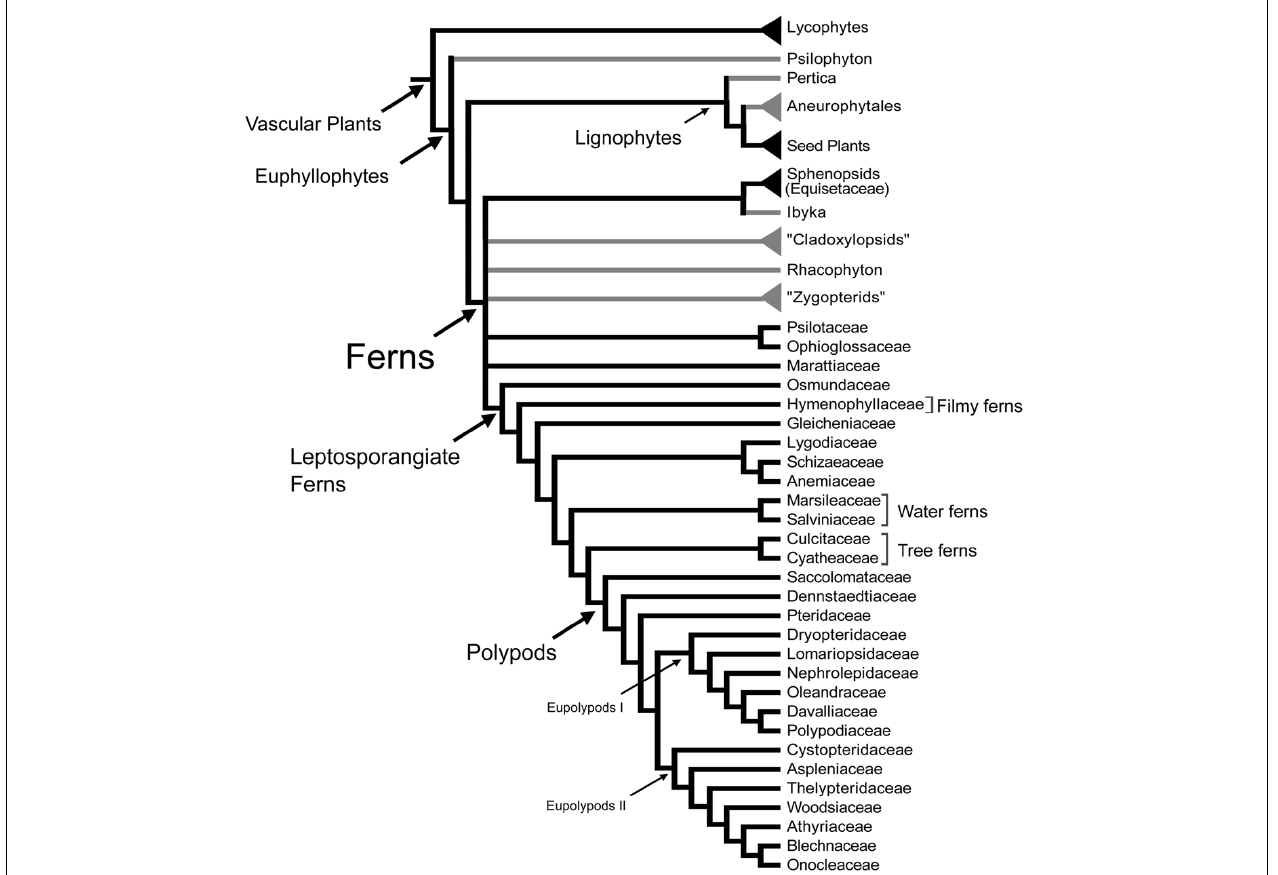
FIGURE 1 | Relationships between vascular plants with an emphasis on the ferns as summarized from morphological and molecular phylogenetic analyses. Topology summarizes the results of previously published studies (Kenrick and Crane, 1997; Doyle, 1998; Pryer et al., 2001;